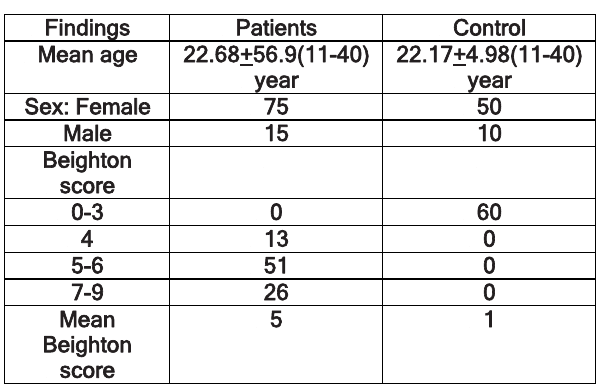
Table (1): Demographic findings of 90 patients with BJHS and 60 controls.